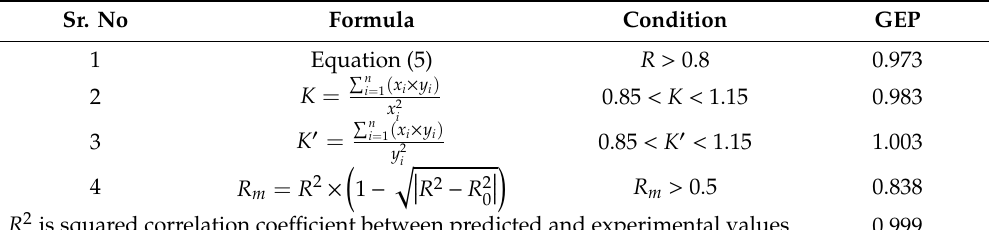
Table 7. GEP model statistical parameters for external